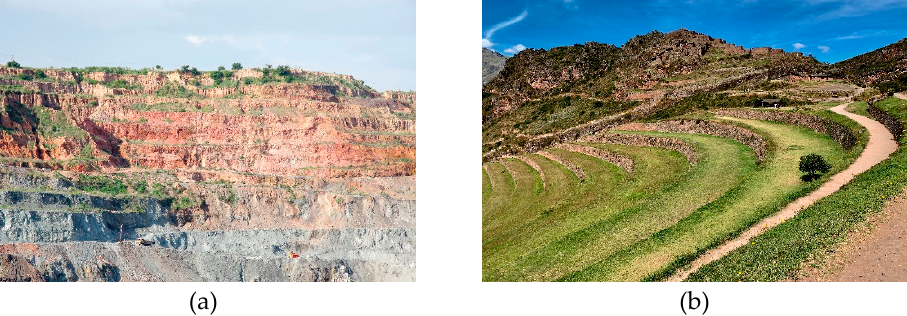
Figure 1. Examples of using berms in real world slopes: ( a ) Slopes with berms in coal mine areas (Dr Ajay Kumar Singh/Shutterstock.com); ( b ) slopes with berms in Peru (lialina/Shutterstock.com).